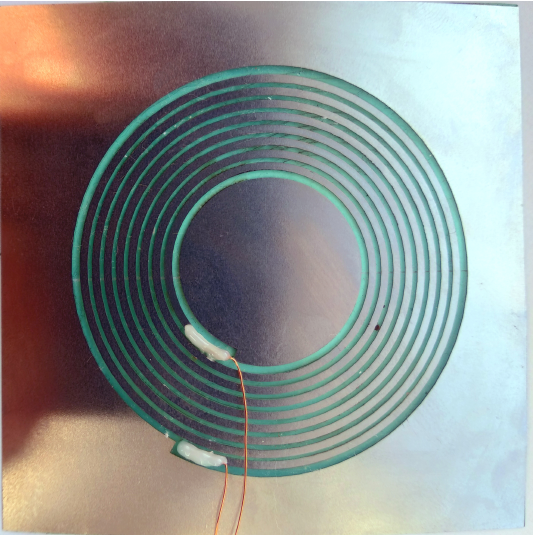
Figure 8. Manufactured antenna produces by FS laser ablation into a contacted stainless-steel